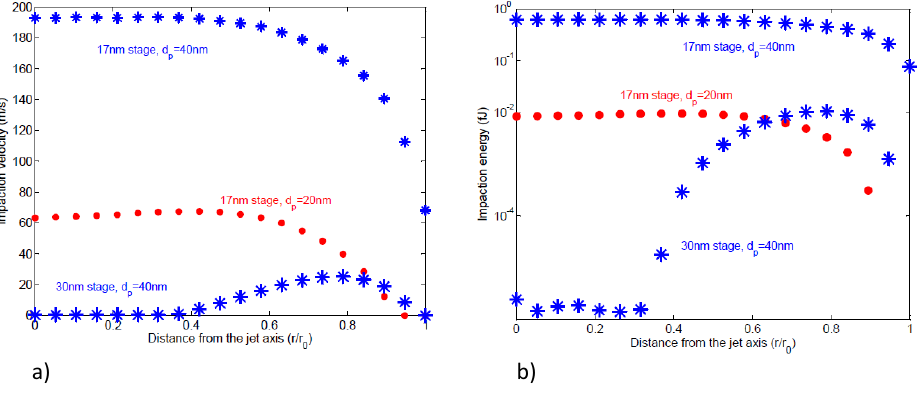
Fig. 3. (a) Calculated impaction velocities and (b) impaction energies for the 20nm particles impacting for the first time on the stage having 17nm cut size (red dots) and 40nm particles (blue stars) impacting on the 30nm stage and 17nm